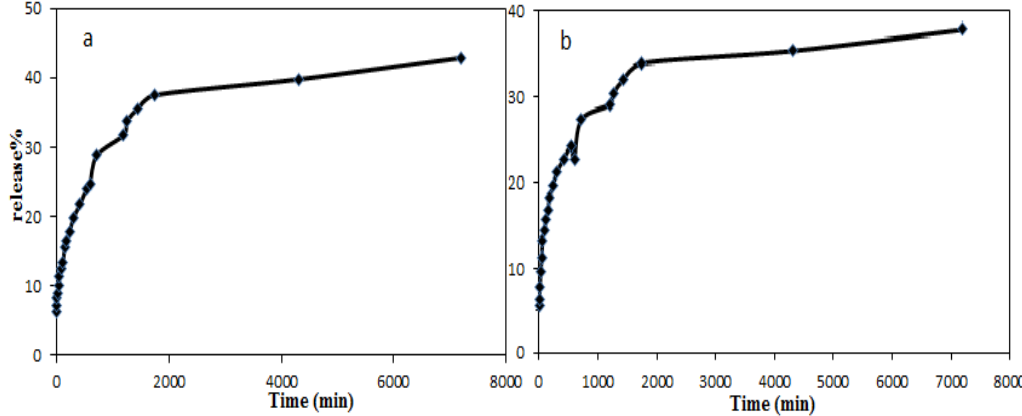
Fig. 6. Release profiles of DOX from nanocarrier in PBS at37˚C (a) pH=6, (b) pH=7.4 Table 1. Simulated equations and correlation coefficients of release curves for different kinetic models Line equations Correlation coefficients Kinetic